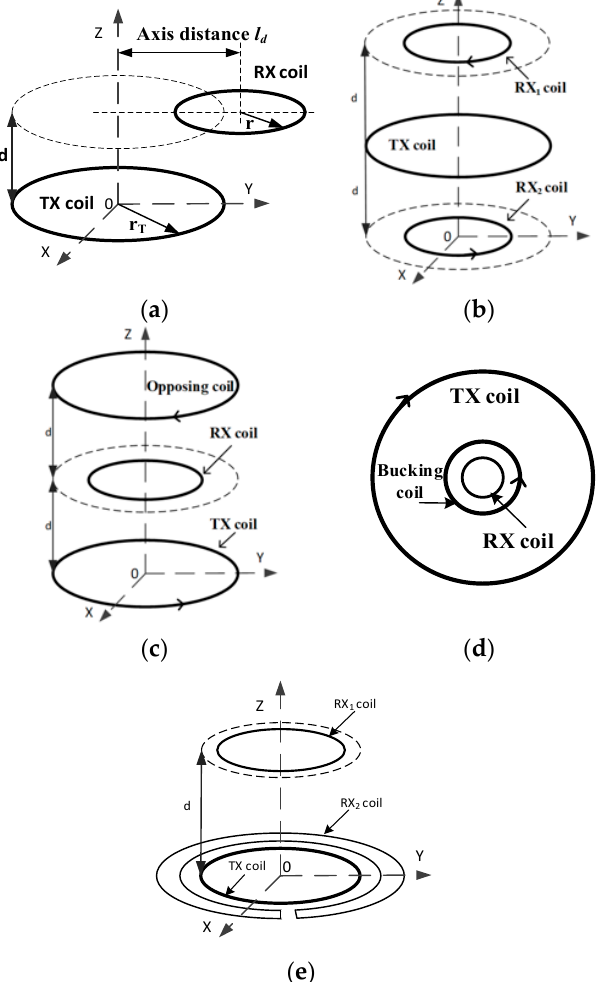
Figure 2. Schematic diagram of five multi-coil designs. ( a ) The eccentric coils. ( b ) The gradient design. ( c ) The opposing design. ( d ) The bucking design. ( e ) The cross-loop design.